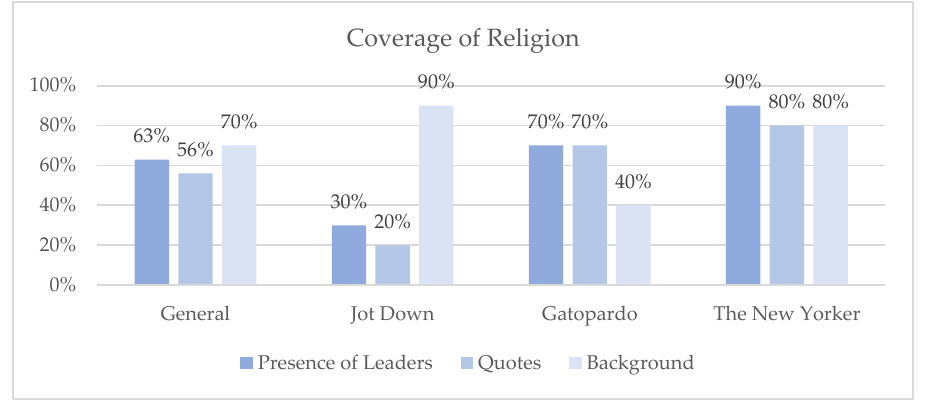
Figure 7. Specific coverage of religion in the publications analysed.